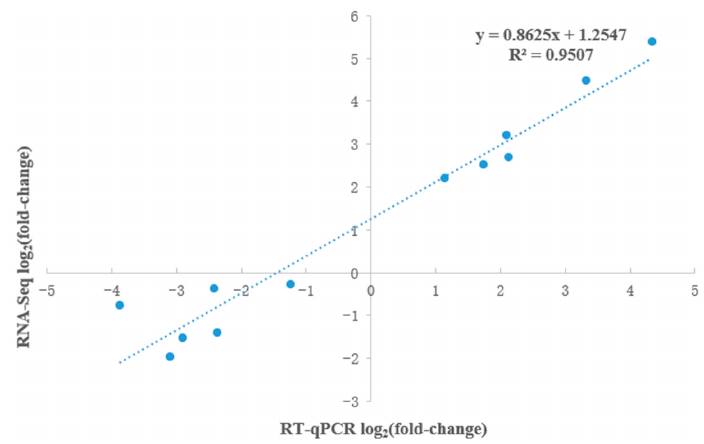
Figure 8. ( A ) qPCR validation of DEGs. A comparison of RNA-Seq and qPCR validation results. The X -axis represents genes in the validated comparison of this study; the Y -axis represents the Log2 ratio for the control and 2,5-HD (40 mmol/L, 24 h) treatment groups. ( B ) Line fit plot of qRT-PCR results and RNA-Seq data showing the linear regression model, R-Squared and expression difference of the selected 12 DEGs (the blue points) between the treatment group (40 mmol/L, 24 h) and the control group (0 mmol/L, 24 h). The X -axis and the Y -axis represent the log 2 ratio for RNA-Seq and RT-qPCR, respectively, between which correlation trend was represented by the blue dotted line All experiments were repeated 3 times. Table 5. Detailed information on the top 10 genes with the highest differential